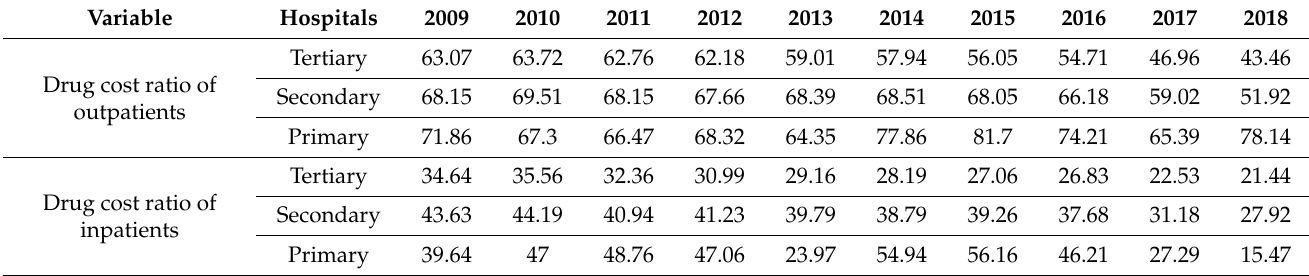
Table 12. Drug cost ratio of outpatients and inpatients of different level public hospitals in Beijing from 2009 to 2018